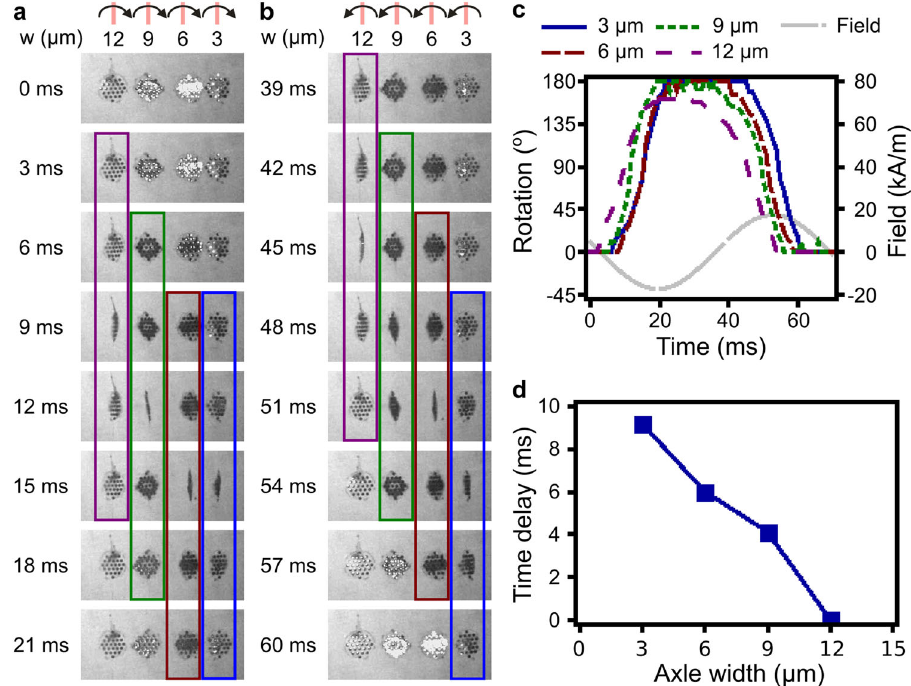
Fig. 4 A metachronal wave in a graded axle width membrane. Microscopy time-sequence images showing actuation of a cell containing paddles on axles of width w = 12, 9, 6 and 3 μ m during a forward and b reverse cycles under a 15 Hz, 1.9 kA/m fi eld. Boxes highlight the movement phase for each paddle. c Time-plot of individual paddle rotations and applied fi eld for the cycle shown in a and b . d Quanti fi cation of the phase differences between paddles on the same cell, measured as the delay in time between when the paddle on the 12- μ m-wide axle reaches 90° rotation (during rotation to 0°) and when every other paddle reaches